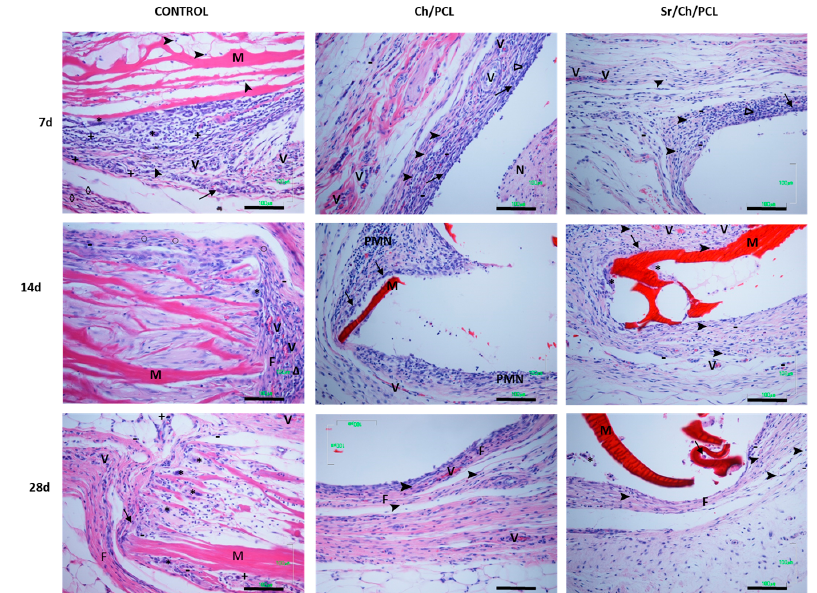
Figure 11. Micrographs of rat subcutaneous tissue responses to Control, Ch/PCL and Sr/Ch/PLC membranes after different implantation times (7, 14 and 28 days). M: membrane; N: necrotic tissue; F: fibrous tissue; V: blood vessels; → : macrophages; * : multinucleated cells; +: mast cells; ➤ : lymphocytes; ◊ : eosinophils; ○ : plasmatic cells; − : monocytes; ∆ : leucocytes; PMN: polymorph nuclear cells. (H-E, 20×, scale bar 100 μ m). Ch: chitosan; PCL: poly( ε -caprolactone).